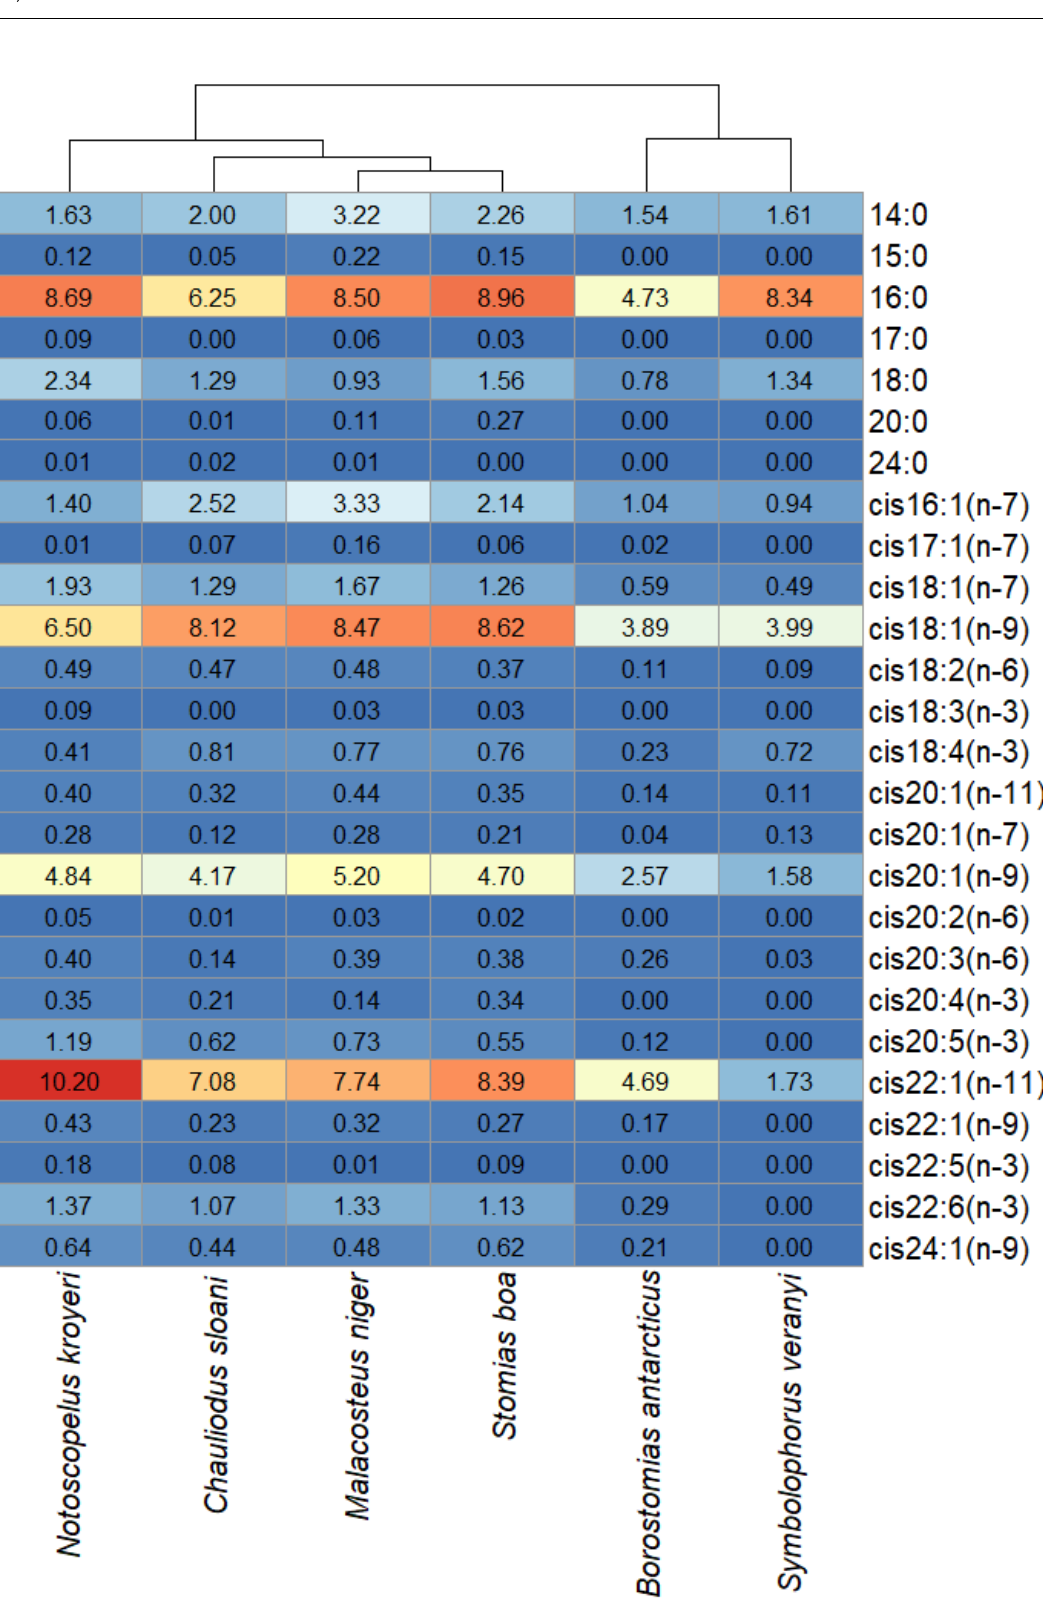
Figure 8. Heat map with species clustered by the quantitative contents ( µ g/mL) of individual fatty acids in storage triacylglycerols in mesopelagic fishes ( Stomias boa , Malacosteus niger , Chauliodus sloani , Borostomias antarcticus, and Notoscopelus kroyeri ) across the depth gradient in the Irminger Sea (North Atlantic).